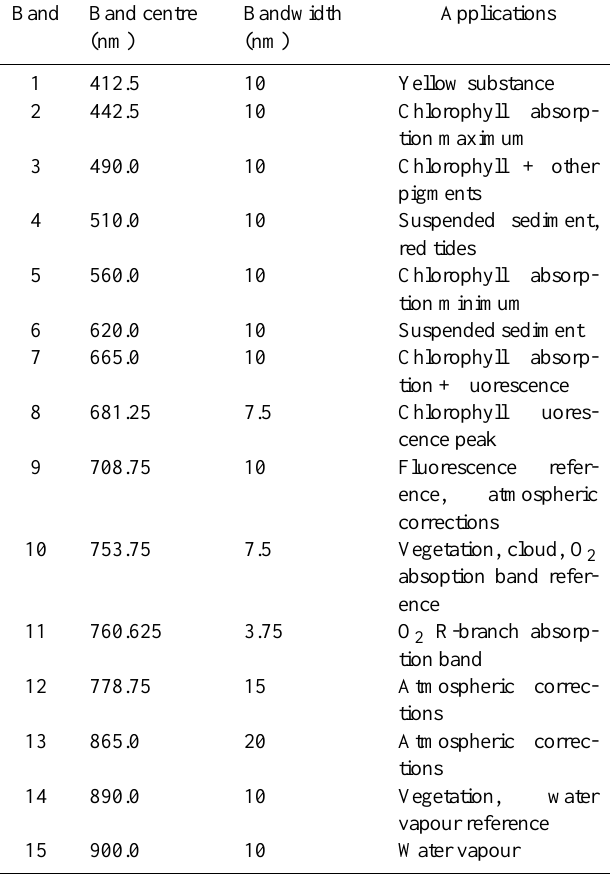
Table 2. Table of the MERIS spectral bands and their applications.